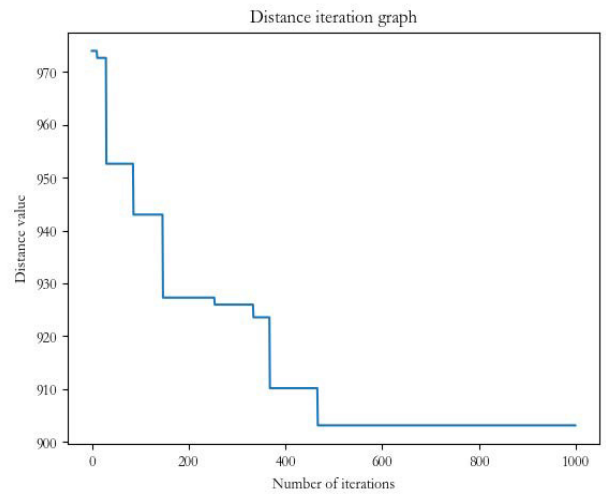
Figure 11. FaCO distance iteration